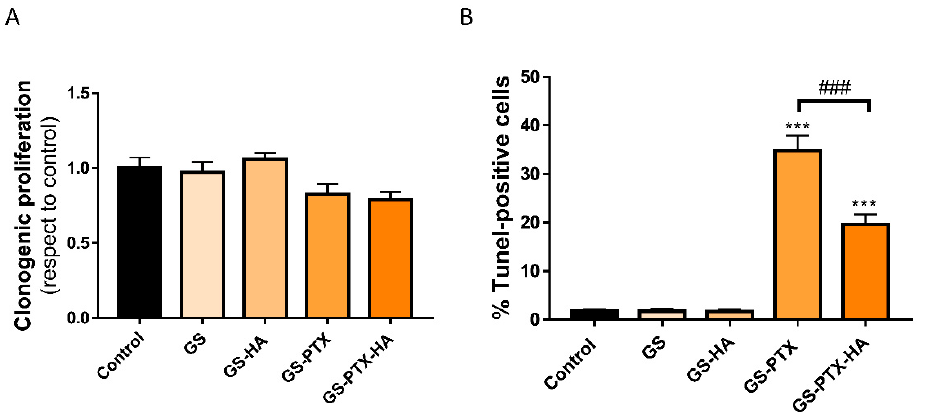
Figure 5. Effect of glycosylated nanosystems on the reproductive capacity and cell apoptosis of non- tumor NMuMG cells. ( A ) Clonogenic proliferation was evaluated (PTX 0.001 µg/mL). ( B ) TUNEL positive cells are depicted (PTX 0.1 µg/mL). Error bars represent the mean ± SEM. ANOVA and Tukey’s multiple comparisons test, *** p < 0.001 vs. control; ### p < 0.001 SG-PTX-HA vs. SG-PTX).